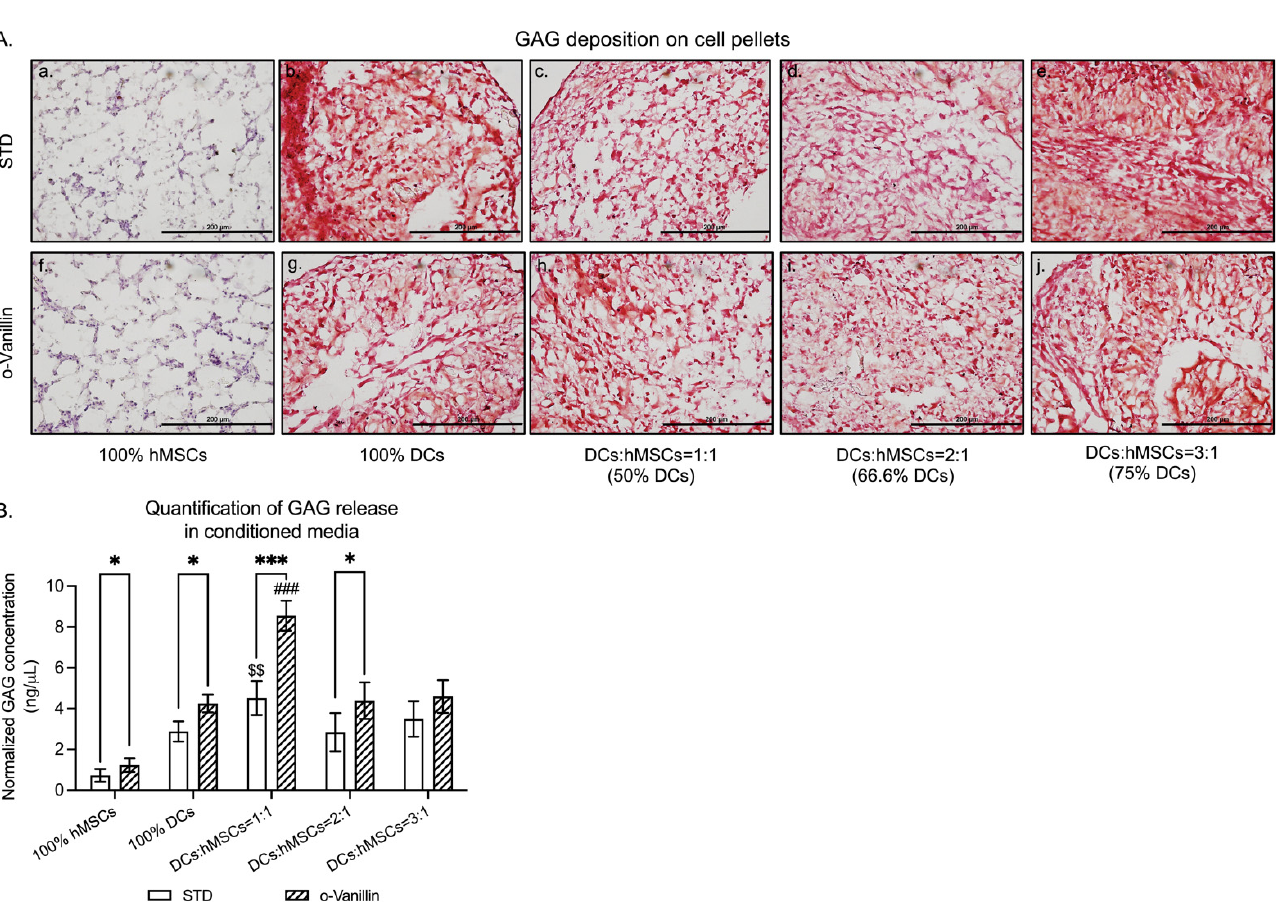
Figure 1. Assessments of sulfated glycosaminoglycan (GAG) synthesis in cell pellets of human mes- enchymal stem cells (hMSCs), human disc cells (DCs), and co-cultures (1:1, 2:1, and 3:1 (DCs:hMSCs)) with and without ortho-Vanillin (o-Vanillin) treatment. ( A ) Representative images showing the GAG deposition in 100% hMSCs, 100% DCs, and co-cultures as assessed by Safranin-O staining. Scale bars: 200 µm. n = 4. ( B ) Evaluation of GAG release in the CM of 100% hMSC, 100% DC, and co-cultures as detected by DMMB assay. n = 5. Values are presented as mean ± SEM. * and *** indicate a statistically significant change assessed by a paired t -test: p < 0.05 and p < 0.001. $$ indicates a statistically significant assessment by a one-way ANOVA among untreated samples: p < 0.01. ### indicates a statistically significant assessment by a one-way ANOVA among o-Vanillin- treated samples: p < 0.001. Additionally, see Figure S3.